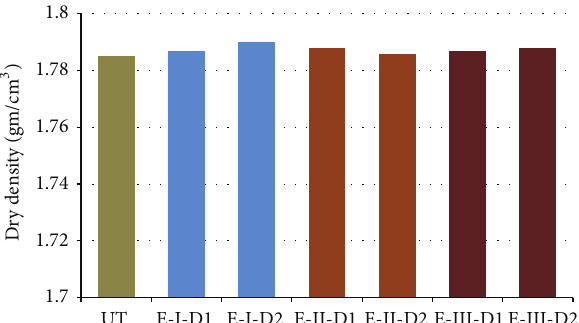
Figure 3: Average maximum dry density for untreated (UT) and treated (E series) samples.